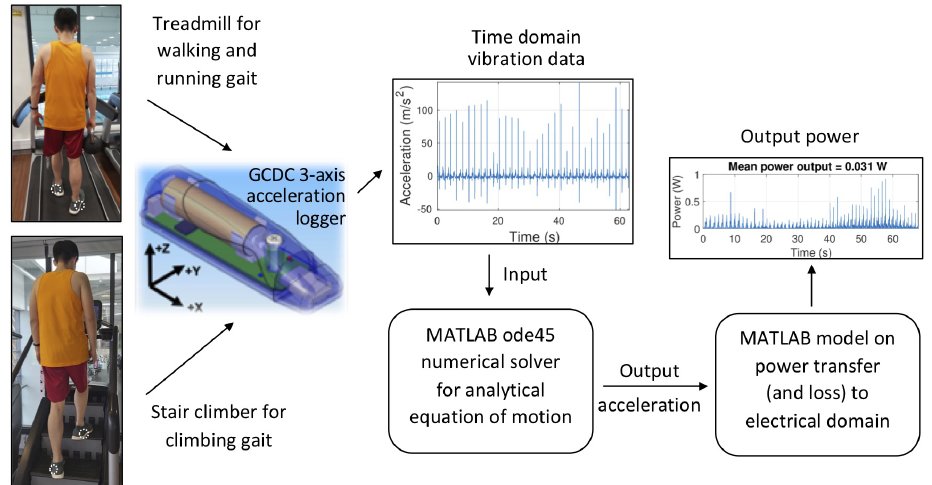
Figure 2. Overview of measurement and numerical simulation method. White dotted circles illustrate the location of the accelerometers, which are fixed on the inside of the